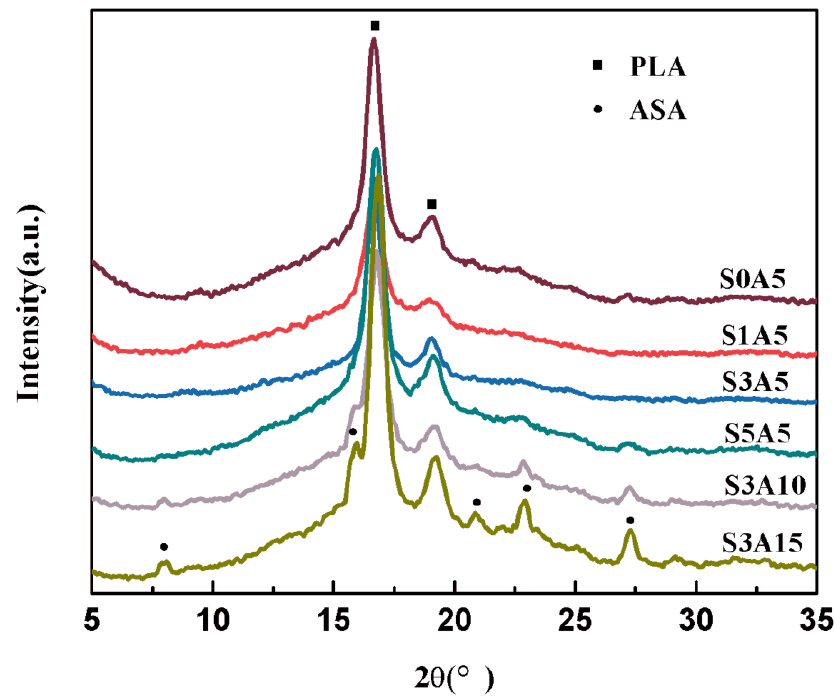
Figure 3. XRD of the double drug ‐ loaded biomimetic composite scaffold.